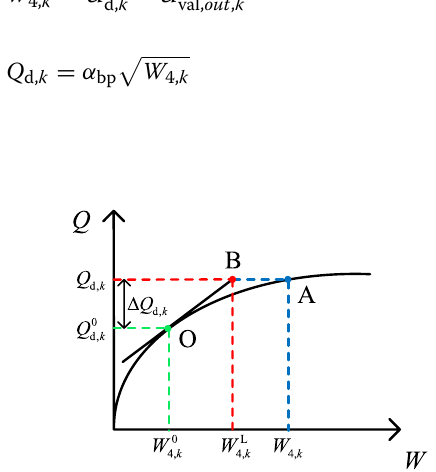
Fig. 5 Linearization of hydrodynamic